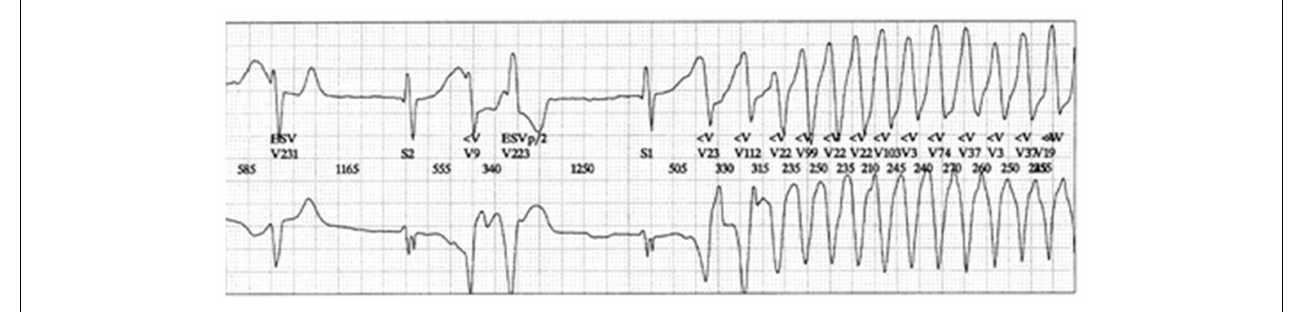
FIGURE 4 |Torsades de pointes.